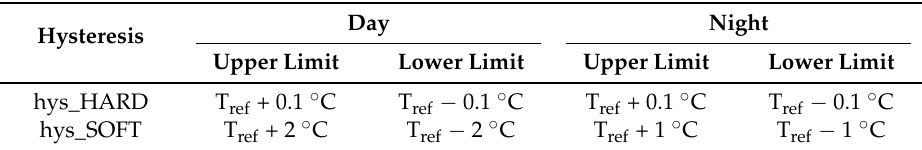
Table 2. Weight values used in the Model Predictive Controls (MPCs).